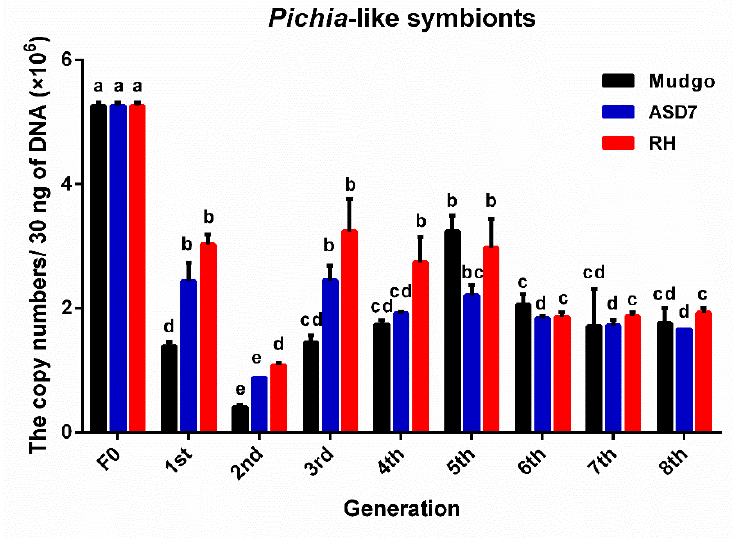
Figure 5. The copy number (×10 6 ) of Pichia-like symbionts of BPH cultivated on three BPH-resistant rice varieties. The F0 generation is BPH raised on TN1 rice. There were significant differences between different lowercase letters ( p ≤ 0.01, one-factor ANOVA, and Tukey’s multiple comparisons).